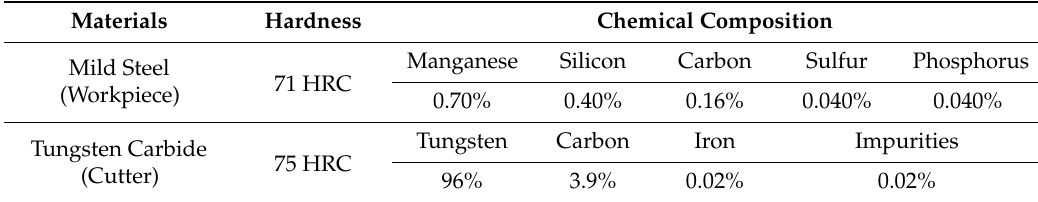
Table 1. Hardness and chemical composition of workpiece and cutter.